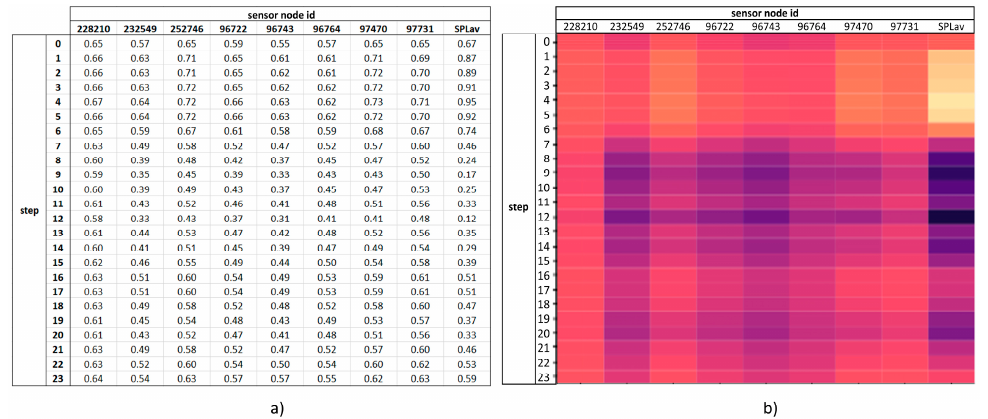
Figure 3. Example of a data sample, showing the normalized hourly measurements during a 24 h period (one day) for each WDN sensor: ( a ) numeric values in tabular form; and ( b ) visual represen- tation using a color scale.